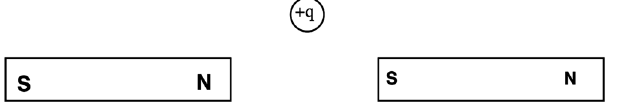
FIG. 5. Diagram provided for Q27. FIG. 6. Diagram provided for